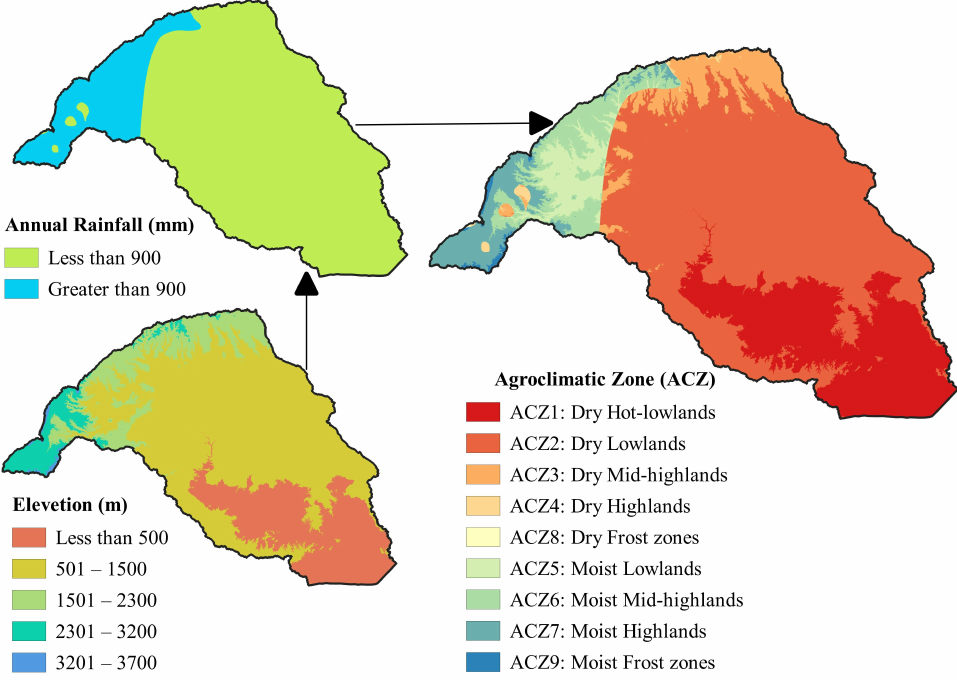
Figure 2. Agroclimatic zone map of WSRB. Table 1. Agroclimatic zones and selected